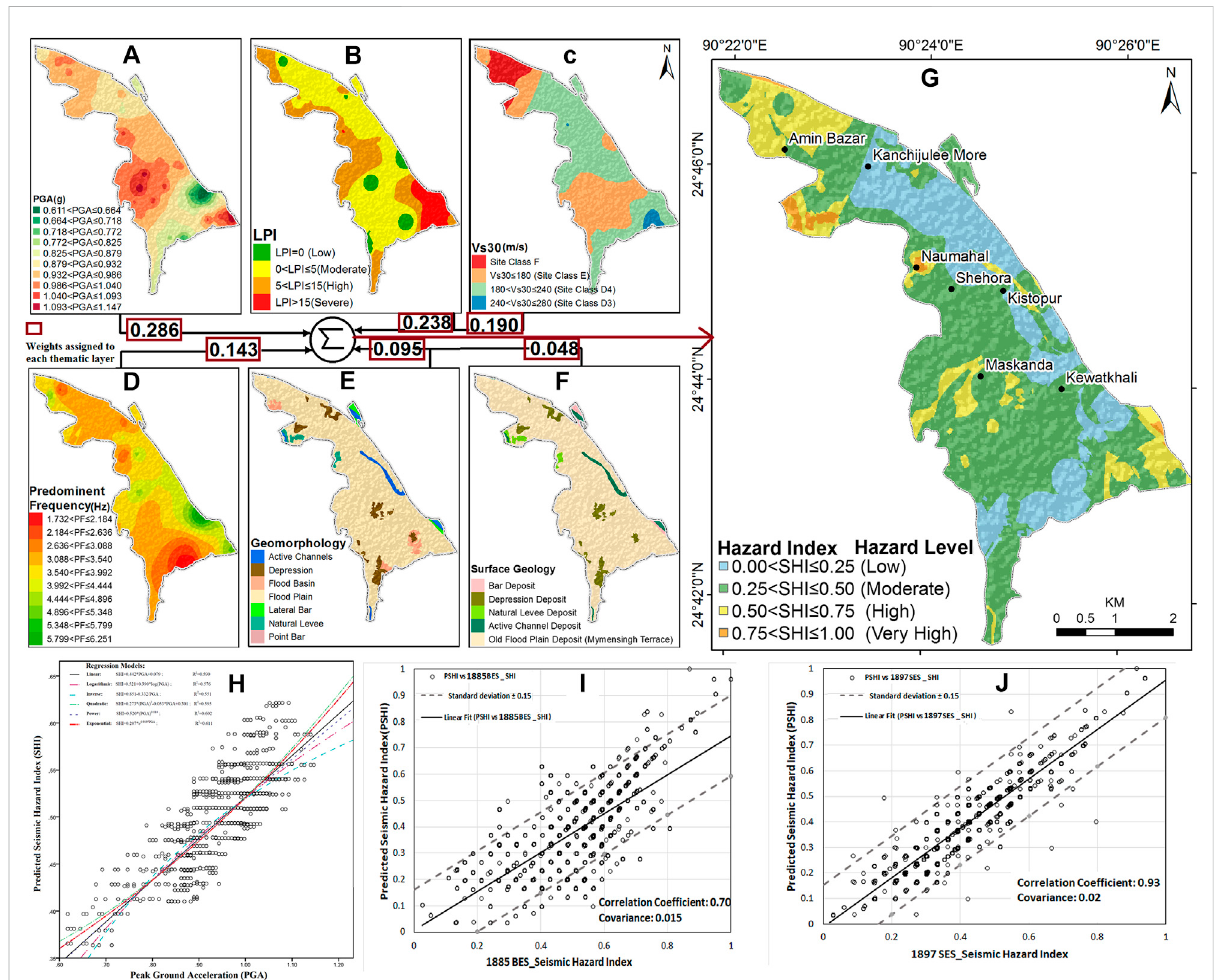
FIGURE 14 PreparationoftheholisticseismichazardmicrozonationmapofMymensinghontheGISplatformbyoverlaying (A) spatiallydistributedsurface- consistent probabilistic peak ground acceleration for 475 years of return period on the geo-hazard thematic layers viz. (B) probabilistic liquefaction potential index distribution, (C) site class map, (D) predominant frequency spatial distribution map, (E) geomorphology map, and (F) surface geology map by assigning individual weights of the order of 0.286, 0.238, 0.190, 0.143, 0.095, and 0.048, respectively, using the analytic hierarchy process and integrating all the themes to produce seismic hazard microzonation map of the city as given in (G) . Various regression relations given in (H) worked out between the seismic hazard index and peak ground acceleration depict an exponential fi t between the two variables. A direct correlation between the probabilistic seismic hazard index of the microzonation map with the scenario hazard theme created for 1885 Bengal earthquake of M W 6.8 through similar integration of scenario PGA with the aforesaid geo-hazard themes and the regression relation just work out produce 0.70 correlation coef fi cient between the two variables with a covariance of 0.015 as shown in (I) , while a similar exercise with 1897 Shillong earthquake of M W 8.1 produces 93% correlation between these variables with a covariance of 0.02 as depicted in (J)